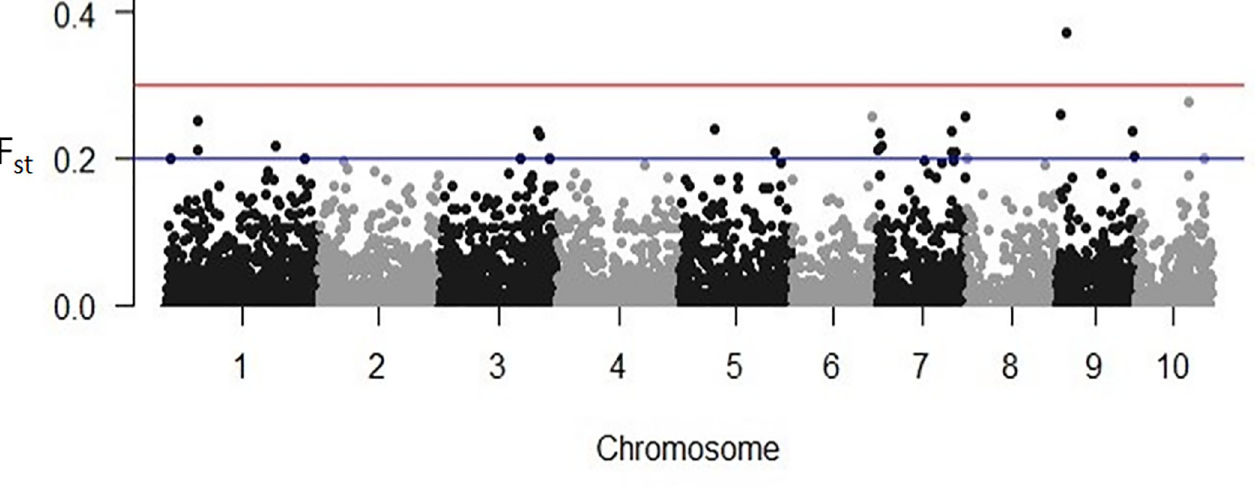
Fig 4. Fst values between H_LNAE and L_LNAE groups of the 12,050 SNPs distributed over the 10 maize chromosomes.